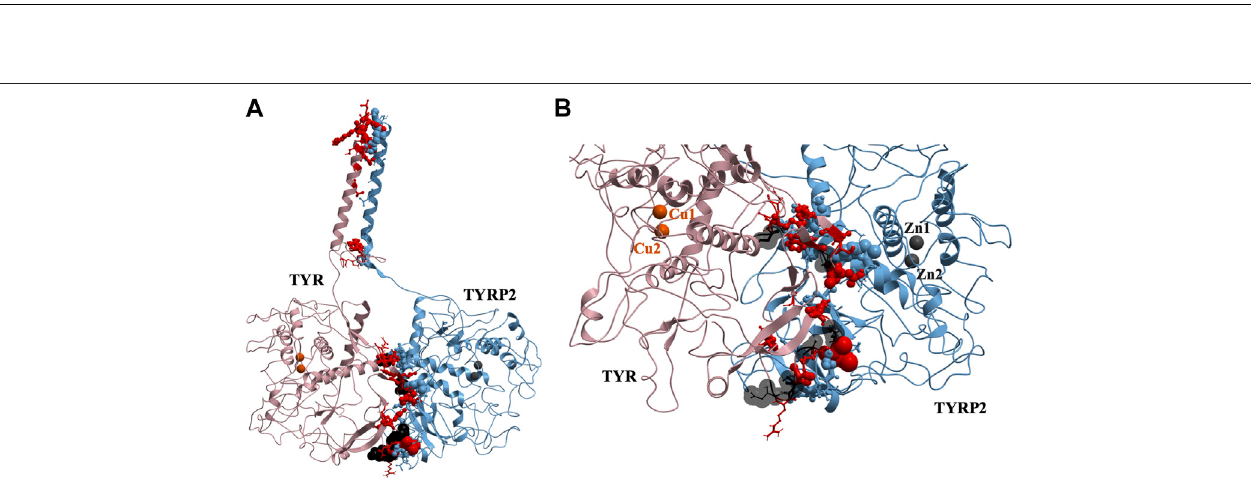
Frontiers in Pharmacology |